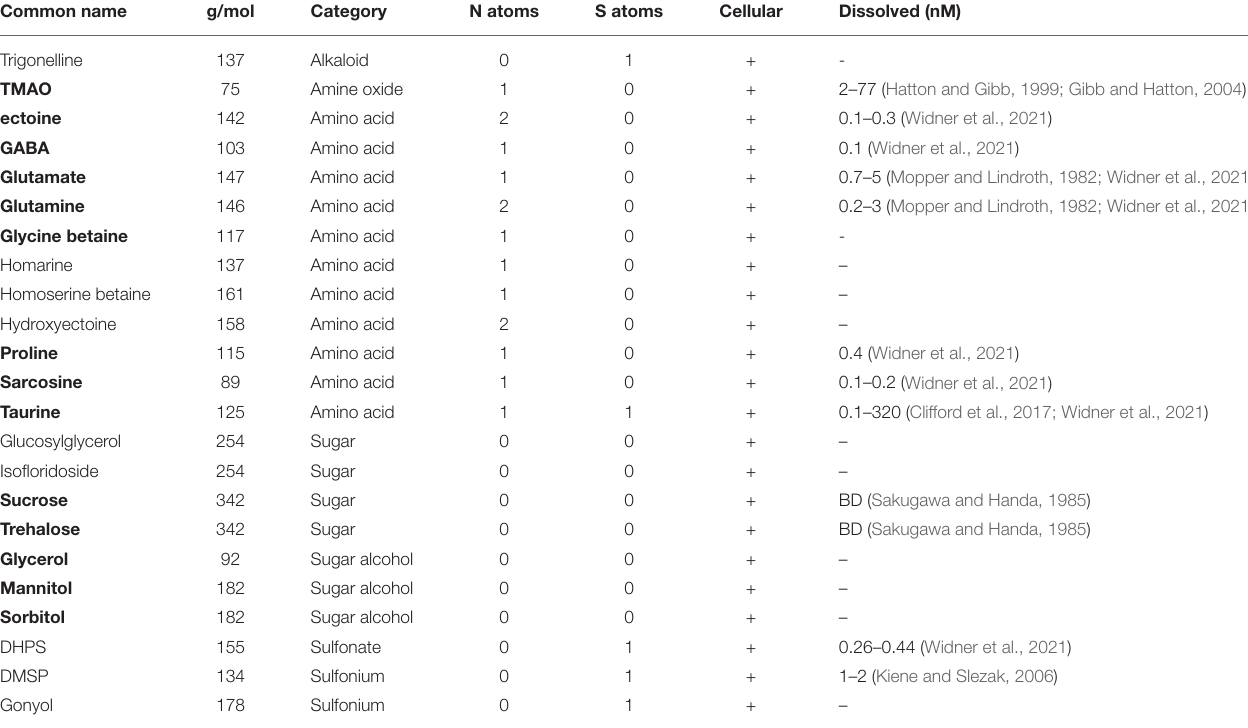
The table includes: Common name of osmolyte, molecular weight (g/mol), nominal category, number of nitrogen (N) atoms, number of sulfur (S) atoms, cellular concentrations reported (+) in monocultures, and previously measured dissolved concentrations (nM) from coastal or open ocean environments. Names in bold were used in the analyses presented here. As osmolytecellularconcentrationsareextremelyvariable,weonlyreportifanosmolytehasbeenpreviouslyreportedinmonocultures(BrownandHellebust,1978;Reedetal.,1986;Dickson